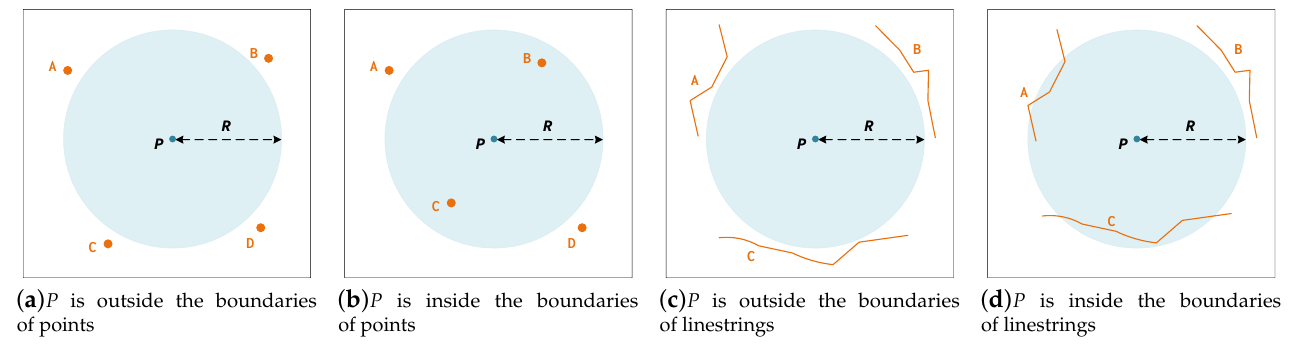
Figure 1. Different situation of pixel P is inside or outside the boundaries of vector